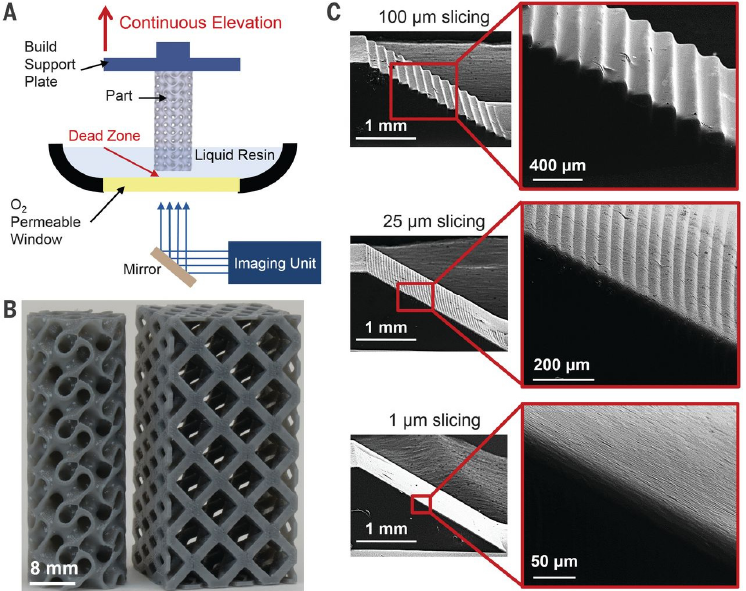
Figure 18 . Gyroid structure printed in microscale with DLP showing ( A ) a diagram of the DLP set-up; ( B ) the gyroid part, printed at 500 mm/h; and ( C ) ramp test prints with slice thicknesses of 100 μ m, 25 μ m and 1 μ m, successively. (From [115], Reprinted with permission from AAAS).